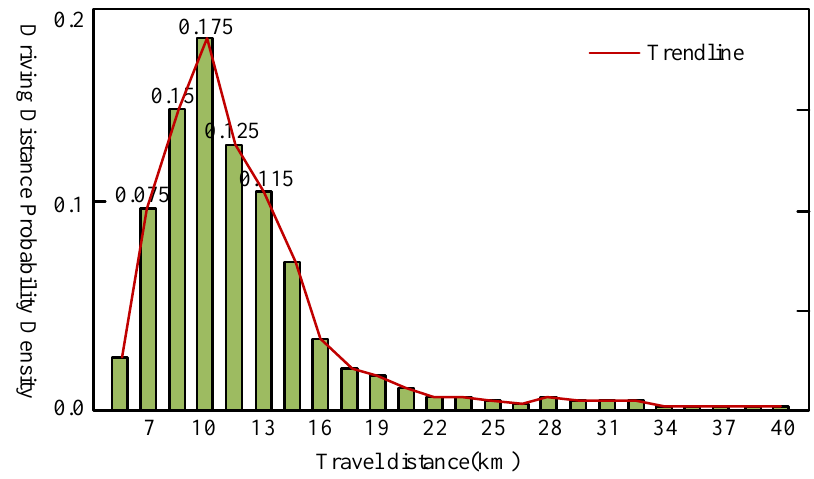
Figure 6. Probability distribution of mileage traveled from home to work (JA). Table 2. Life comparison of electric vehicles under different conditions.